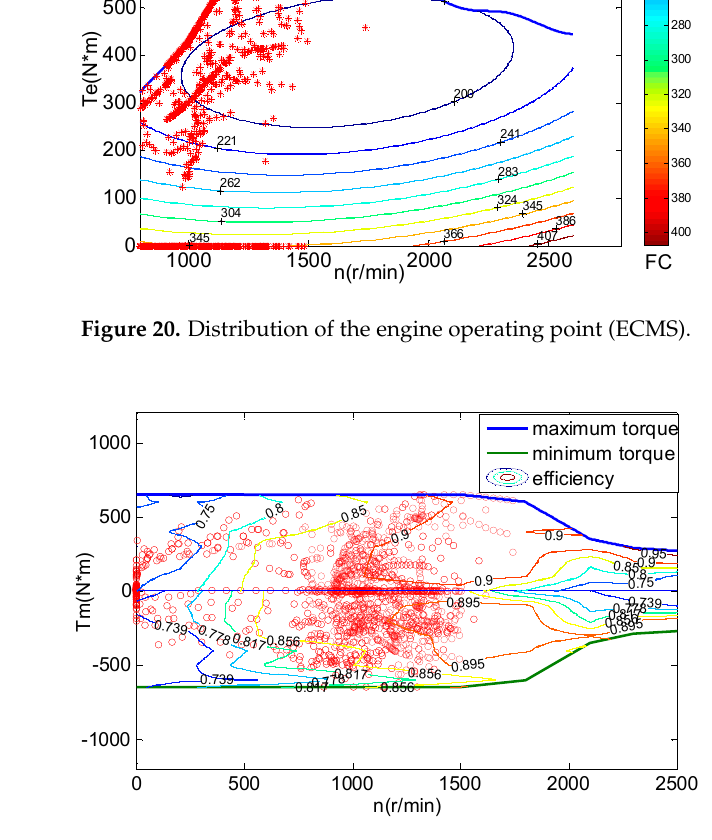
Figure 21. Distribution of the motor operating point (ECMS). Energies 2016 , 9 , 919